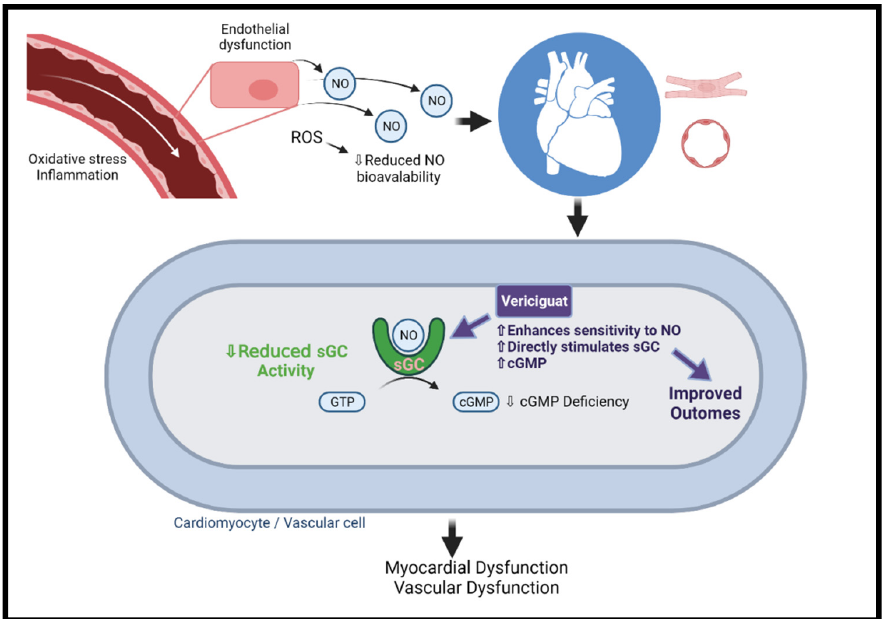
Figure 2. The mechanism of vericiguat. Under normal conditions, NO is generated in endothelial cells and diffuses to neighboring tissues. NO enters vascular/cardiac muscle cells in the heart and stimulates the intracellular receptor sGC to generate cGMP. In HF, there is endothelial dysfunction due to oxidative stress and inflammation and ROS, and ROS reduce NO bioavailability, leading to insufficient activation of sGC. The resulting cGMP deficiency is associated with microvascular dys- function, cardiomyocyte stiffness, and fibrosis, ultimately leading to myocardial dysfunction. Ver- iciguat can sensitize sGC and directly stimulate the enzyme to the limited amounts of endogenous NO. cGMP = cyclic guanosine monophosphate; NO = nitric oxide; ROS = reactive oxygen species; sGC = soluble guanylate cyclase. Created with BioRender.com. 3.3. Omecamtiv Mecarbil Myocardial contraction is a result of chemical energy transformation into mechanical energy. Actin, myosin, and other regulatory proteins generate the force needed for con- traction. It also involves ATP hydrolysis and myosin–actin cross bridging, which both play a key role in cardiac contractility [89]. Inotropic drugs increase myocardial contrac- tility through the increase in intracellular cAMP and calcium through different mecha- nisms. However, the use of inotropes is associated with increased myocardial oxygen con- sumption and tachyarrhythmia, which may increase mortality as shown in previous stud- ies [89–91]. Omecamtiv mecarbil, formerly known as CK-1827452, was the first agent developed to accelerate the transition of the actin–myosin complex from weakly bound to a firmly bound configuration (Figure 3) [90–92]. Omecamtiv mecarbil was found to improve car- diac function in patients with HFrEF. However, higher infused doses have led to cardiac ischemia in some cases [92,93]. Safety and tolerability were tested and found not to be different from placebo, including time to angina, exercise duration, or ischemic ECG changes [94].